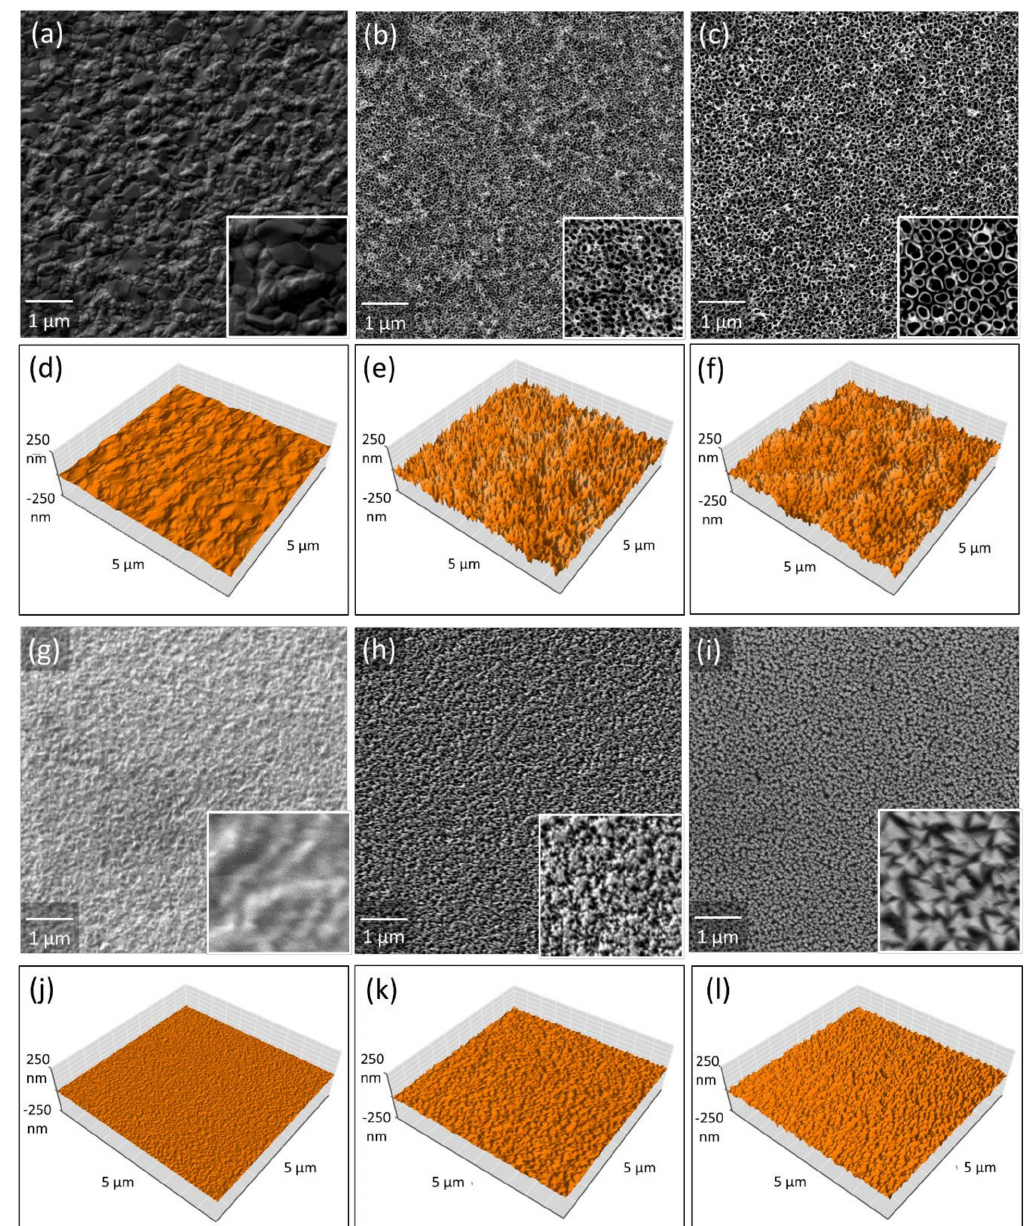
Figure 2. Surface characterization. ( a ) Scanning electron microscopy (SEM) picture displaying the smooth, mirror-like Ti film, deposited on a glass substrate at a substrate temperature of 200 ◦ C; ( b , c ) TiO 2 NTs generated by 2h-anodization of the Ti coatings at 10 and 20 V in an H 3 PO 4 / HF electrolyte. AFM scans of 5 µ m × 5 µ m areas in 3D view; ( d ) untreated Ti film deposited on a pre-heated glass substrate; ( e , f ) TiO 2 NT arrays generated by anodization with voltages of 10 and 20 V in H 3 PO 4 / HF electrolyte—Figure 2 ( a – f ) reprinted with permission from [36]; ( g ) Smooth TiN coating produced with the substrates heated to 200 ◦ C; ( h , i ) Nanorough TiN coatings deposited on unheated substrates with deposition times of 15 (TiN 15), or 60 (TiN 60) minutes, respectively. Small inserts depict higher magnification images with areas of 1 µ m × 1 µ m; ( j ) Atomic force microscopy scans of 5 µ m × 5 µ m areas in three-dimensional (3D) view of smooth TiN coating and ( k , l ) nanorough TiN